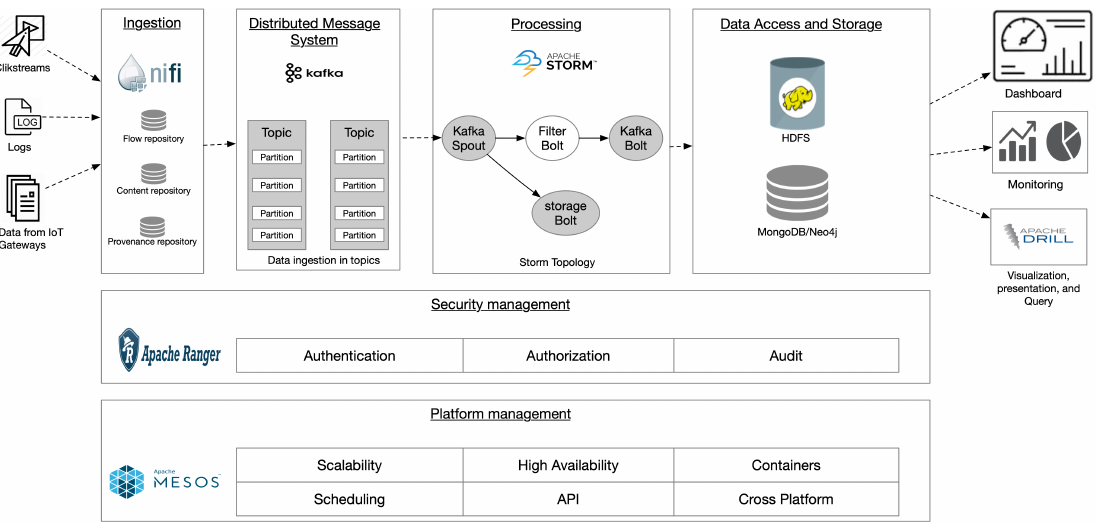
Figure 8. Data processing at the